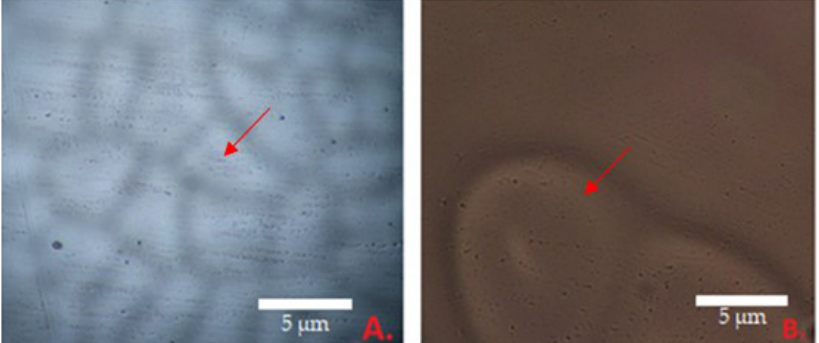
Figure 3. The surface of the film 40 × magnification: ( A ) film No. 5; ( B ) film No. 5K (control compositions); arrows show the dimples of the film